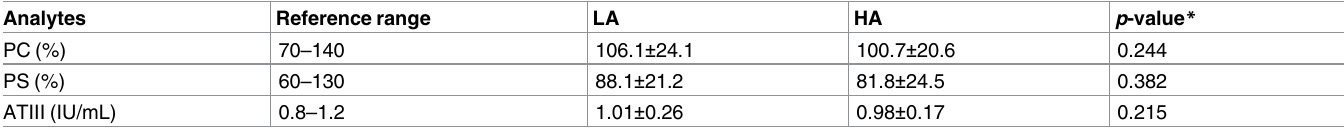
Fig 1. The results coagulation factors of different altitude blood donors. LA, blood donorsreside at low altitude(500 m); HA, blooddonors reside at high altitude(3,700 m). Values are mean ± SD. LA, n = 46; HA, n = 41. ** p < 0.001, * p < 0.05,when comparedLA blood donors and HA blood donors using independent sample Student’s t -tests. https://doi.org/10.1371/journal.pone.0176390.g001 Table 4. Anticoagulant factors of different altitude blood donors §